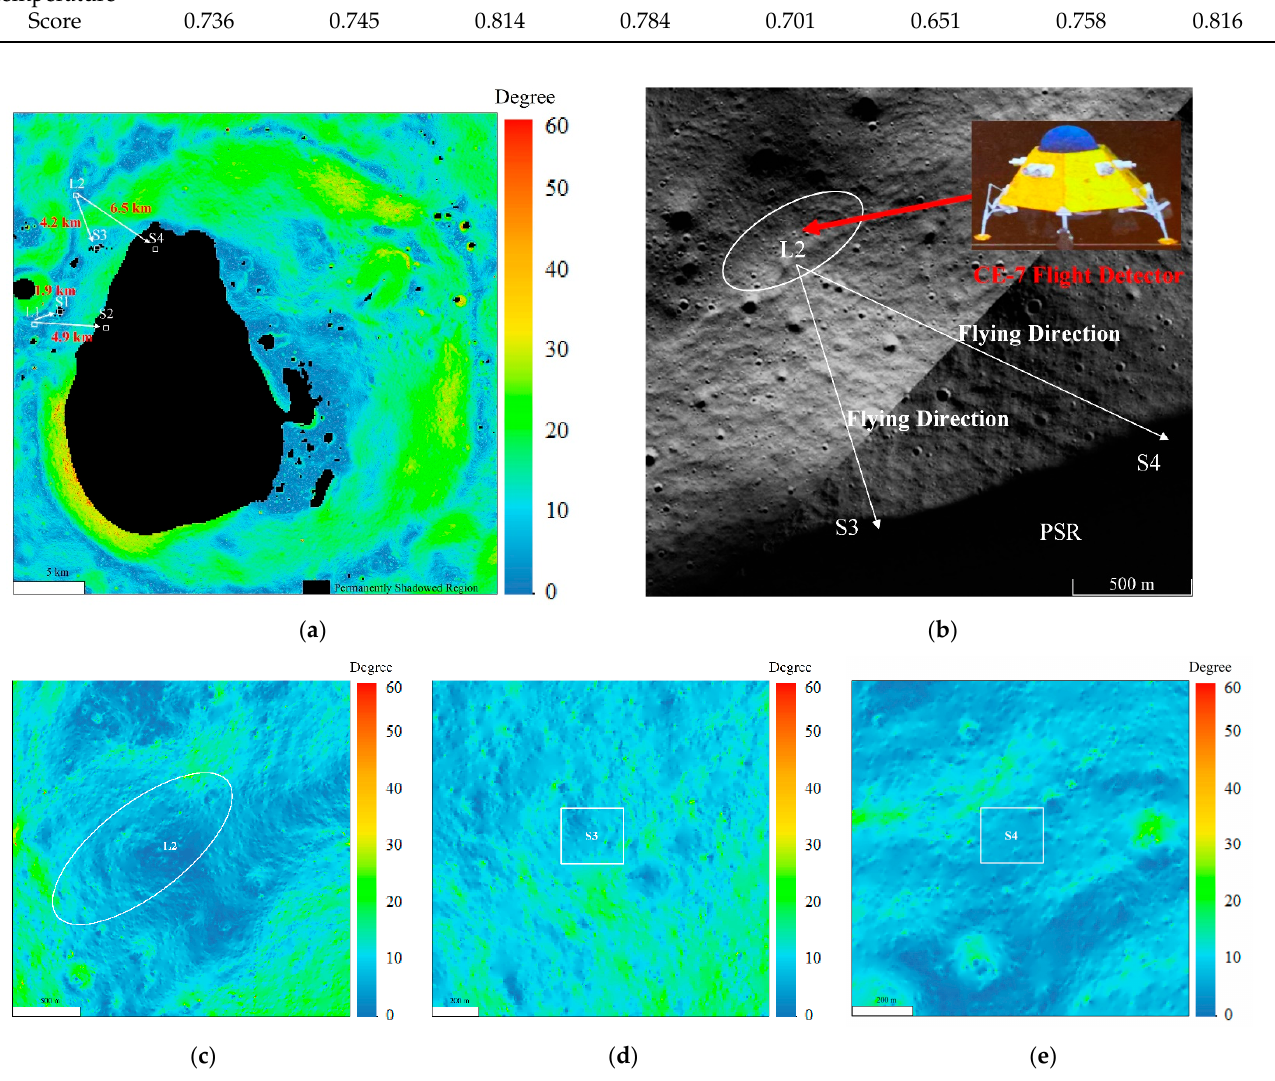
Figure 18. The de Gerlache Crater: ( a ) Slope angle and PSRs of the de Gerlache Crater; ( b ) The LROC NAC image; ( c ) The slope angle of L2; ( d ) The slope angle of S3; ( e ) The slope angle of S4. For the de Gerlache Crater, we choose two elliptical landing zones, L1 and L2, and analyze two routes for each, L1 − S1, L1 − S2, L2 − S3, and L2 − S4. Figure 17a shows that the flight distances of L1 in S1, and S2 for exploring the shadowed area are 1.9 km and 4.9 km, respectively, where S1 is at 88.04°S, 85.30°W, and S2 is at 88.15°S, 86.02°W. The flight dis- tances of L2 are also 4.2 km, and 6.5 km, respectively, with S3 located at 88.11°S, 80.78°W and S4 at 88.23°S, 79.92°W. We also analyze L2 − S3 and L2 − S4 to explore the presence of water ice. Figure 18b shows the LROC NAC image indicating the flight path of CE-7. Fig- ure 19c–e are the slope analysis diagrams for L2, S3, and S4, respectively, where the reso- lution is 20 m. For L2 − S3, the mini-flyer can reach the sampling sites for which the detailed analysis is shown in Figure 19.